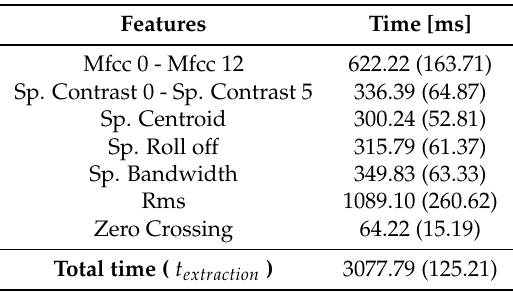
Table 13. Average time required for the feature extraction on the Raspberry Pi. The values in brackets are the Standard Deviation